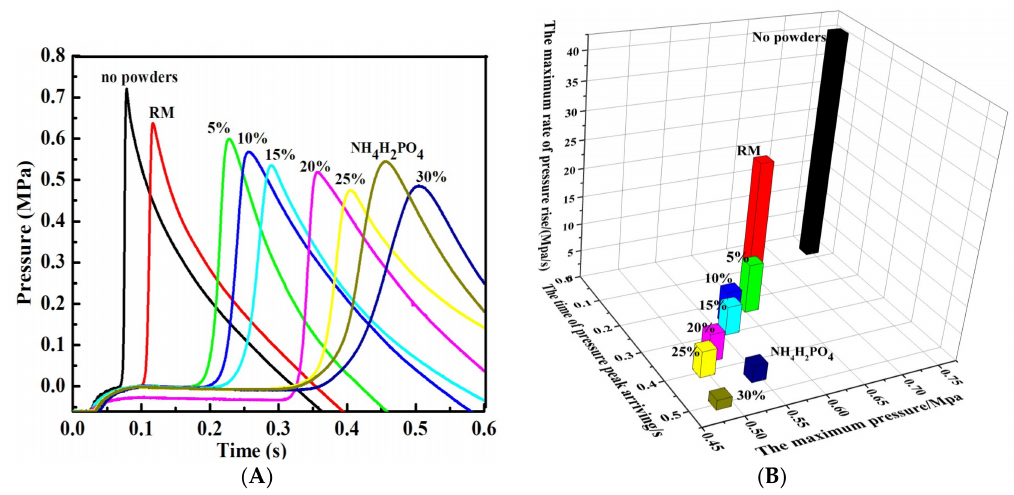
Figure 6. The suppression effect of NH 4 H 2 PO 4 /RM composite powders: the explosion pressure curves ( A ), the maximum pressure, the maximum rate of pressure rise, and the time of pressure peak arriving ( B